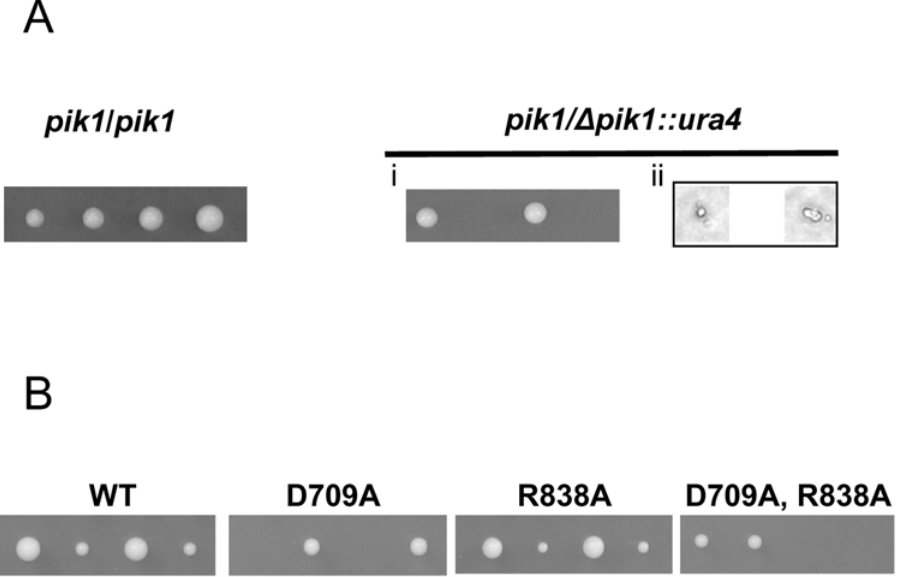
Figure 1. Tetrad analysis following S.pombepik1 disruption and mutant allele integration. (A) Diploid cells pik1/pik1 or pik1/ D pik1 :: ura4 (N1231) were incubated on ME plates to obtain azygotic asci. Spores were separated and incubated on YES plates. Results shown are representative of 8–10 asci. Each spore formed a colony when both chromosomal pik1 loci were intact (left panel). Only two of the four spores formed colonies when only one chromosomal locus was intact (right panel; i). In cases where colonies did not form, the site of spore deposition was examined microscopically and photographed (right panel; ii). Many spores failed to germinate. Some spores germinated but the resulting cell divided only once. (B) A diploid strain (N1550) homozygous for the wild-type pik1 coding region (WT), or heterozygous diploid strains carrying either the D709A substitution (N1565) or the R838A substitution (N1582), or both (N1596) were examined to evaluate the effects of the substitutions. For strains N1550 and N1582, each of four spores formed colonies. For strains N1565 and N1596, colonies were formed from only 2 of 4 spores. Results from one representative tetrad are shown for each strain.